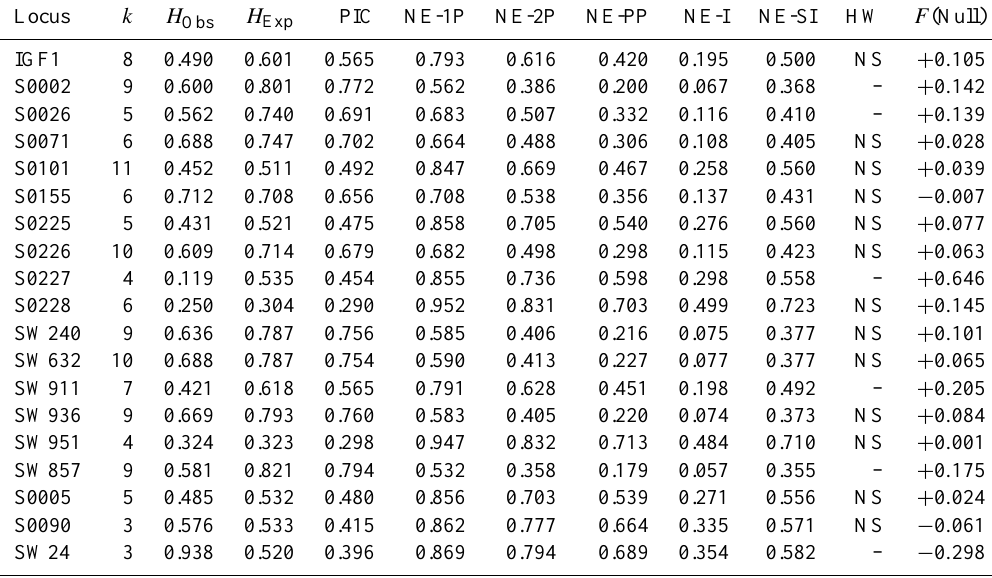
Table 1. Description of the informative ability of the 19 polymorphic microsatellites genotyped.